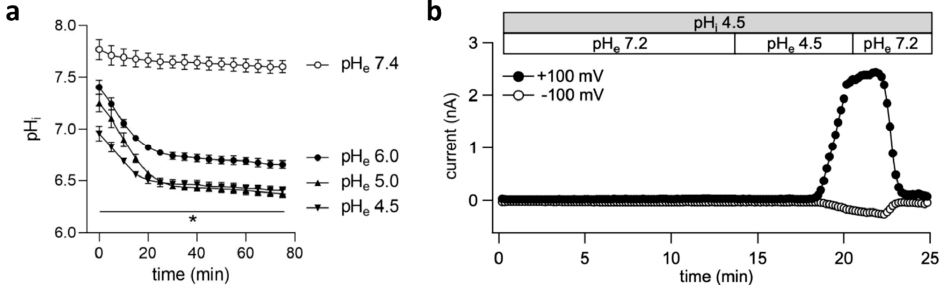
Figure 3. ASOR current activation is dependent on extracellular, but not intracellular acidification: ( a ) Time courses of the intracellular pH (pH i ) in response to extracellular acidification (pH 6.0, 5.0 or 4.5;